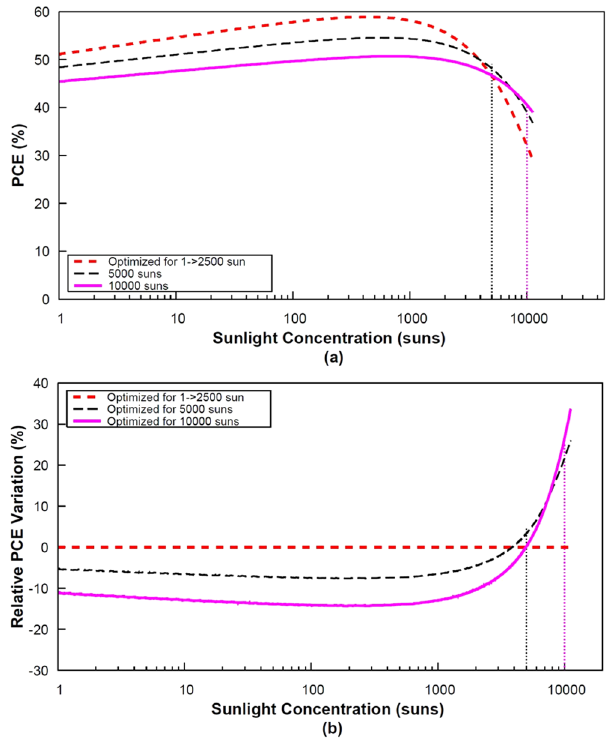
Figure 6. PCE ( a ) and relative PCE variation ( b ) as a function of sunlight concentration for 3-J cells with a total series resistance of 0.01 Ω cm 2 .